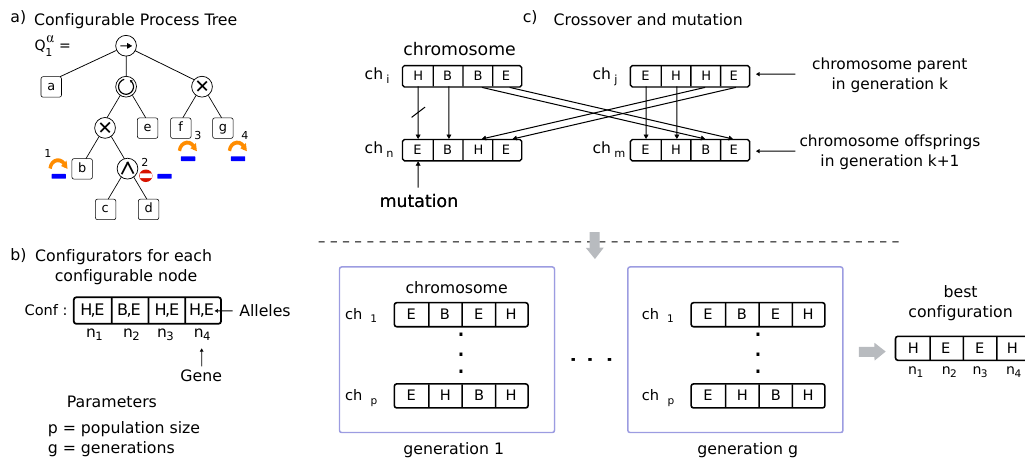
Figure 7. Overview of the genetic strategy to derive a process tree. The internal configuration representation allows this evolutionary algorithm to use crossover and mutation operations to generate new candidate configurations to be